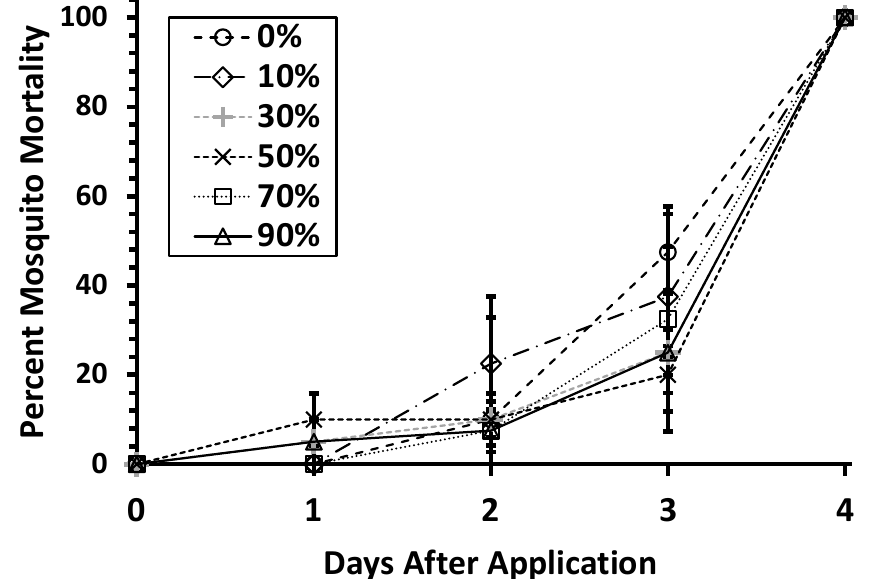
Figure 3. Percent mortality of Ae. aegypti when exposed to mosquitocidal chips containing 0.01% Pyriproxyfen in containers with water at different concentrations of organic matter. No mortality was observed in untreated controls (not shown). Error bars represent ± SEM.